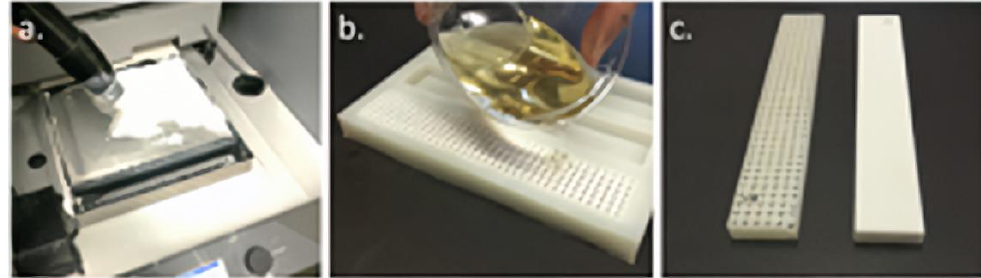
Figure 15. Manufacturing steps for 3DPIC: ( a ) 3D printing, ( b ) epoxy infiltration and casting, and ( c ) cured examples of a 50% 3DPIC (left) and 100% 3DPIC (right) [83].